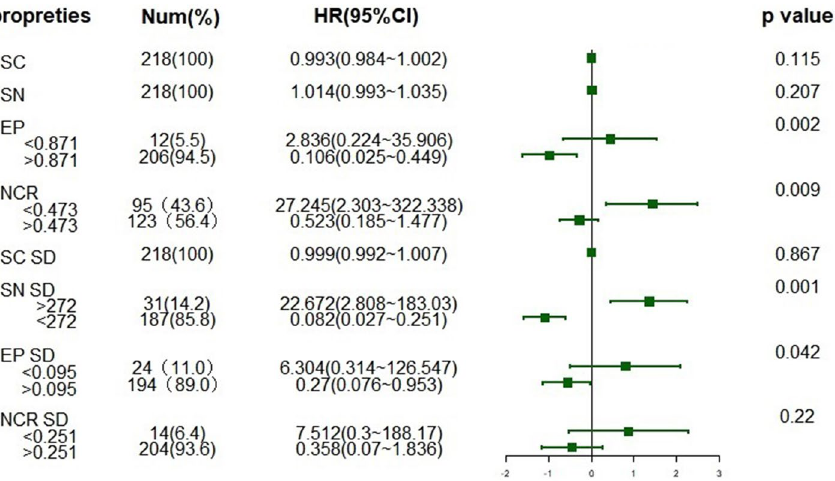
Figure 4. Forest plot of lymph node involvement in colorectal SRCC. The cutoff value of each index is calculated by the Youden’s index and its corresponding optimal cutoff point. HR hazard ratio. X axis is scaled by logarithmed